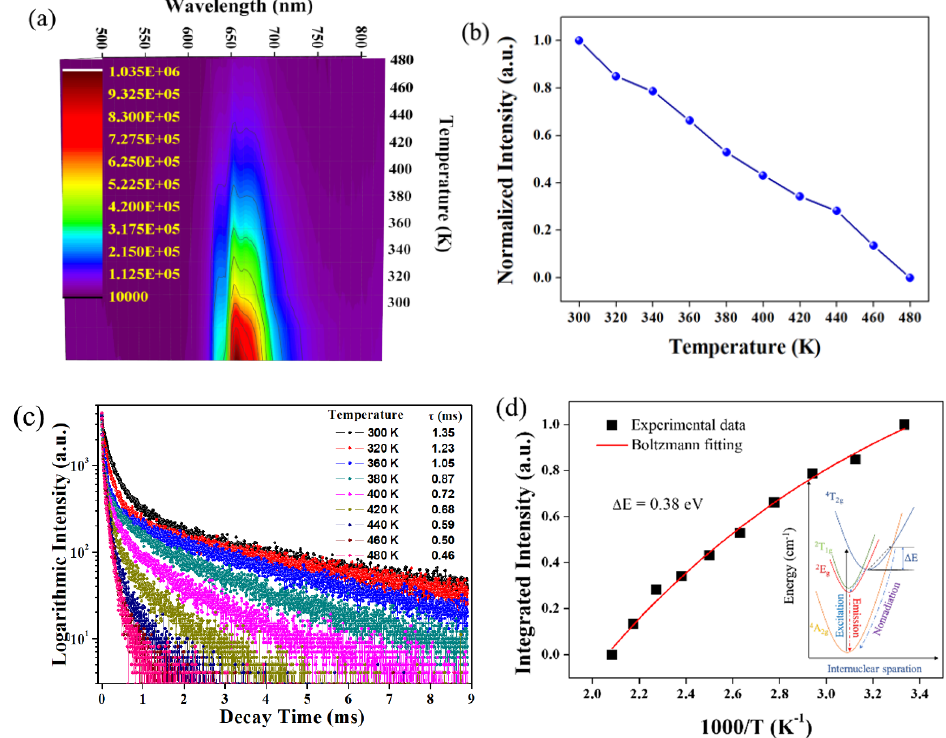
Figure 8. ( a – c ) Temperature-dependent emission spectra, integrated intensity, and lifetime of LMA/0.01Mn 4+ , respectively; ( d ) configurational coordinate diagram of Mn 4+ in the LMA host for the possible thermal quenching process.